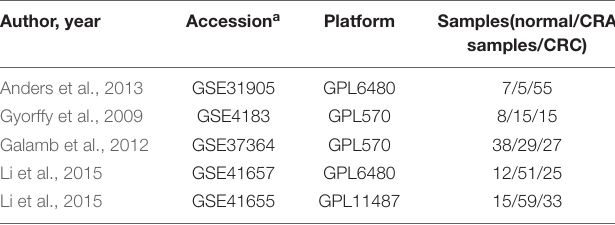
TABLE 1 | Characteristics of mRNA and miRNA expression profiles of colorectal